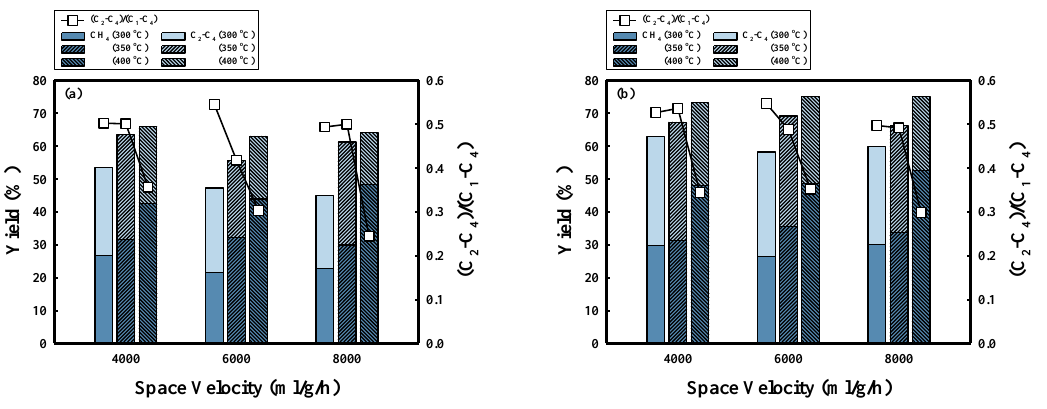
Figure 5. C 1 – C 4 yield and (C 2 – C 4 )/(C 1 – C 4 ) ratio of the FT catalyst (5Co- 15Fe/γ -Al 2 O 3 ) as a function of Figure 5. C 1 –C 4 yield and (C 2 –C 4 ) / (C 1 –C 4 ) ratio of the FT catalyst (5Co-15Fe / γ -Al 2 O 3 ) as a function of space velocity at ( a ) 10 bar and ( b ) 20 bar space velocity at ( a ) 10 bar and ( b ) 20